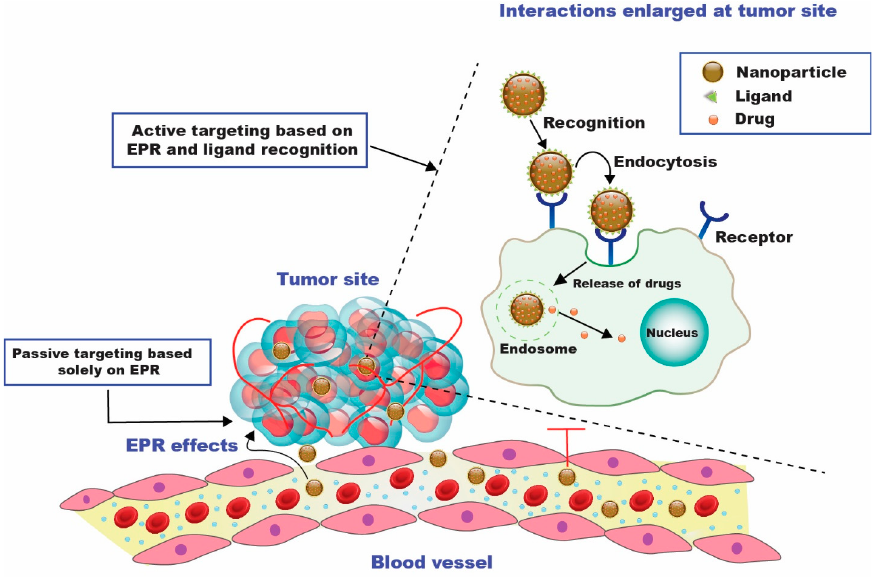
Figure 2. Diagrammatic representation of passive and active drug targeting techniques. For passive targeting, the enhanced permeability and retention (EPR) effect causes the nanocarriers to aggregate at the tumor site after passing through the leaky walls. Active targeting can be accomplished by utilizing certain ligands specific to the over-expressed receptors on the tumor cells